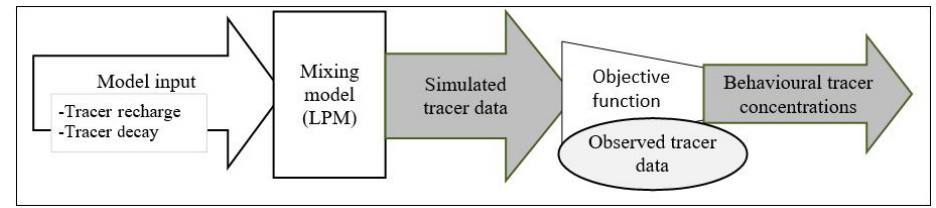
Figure 3. Schema of the modelling approach with framework components: model input, mixing model and objective function.